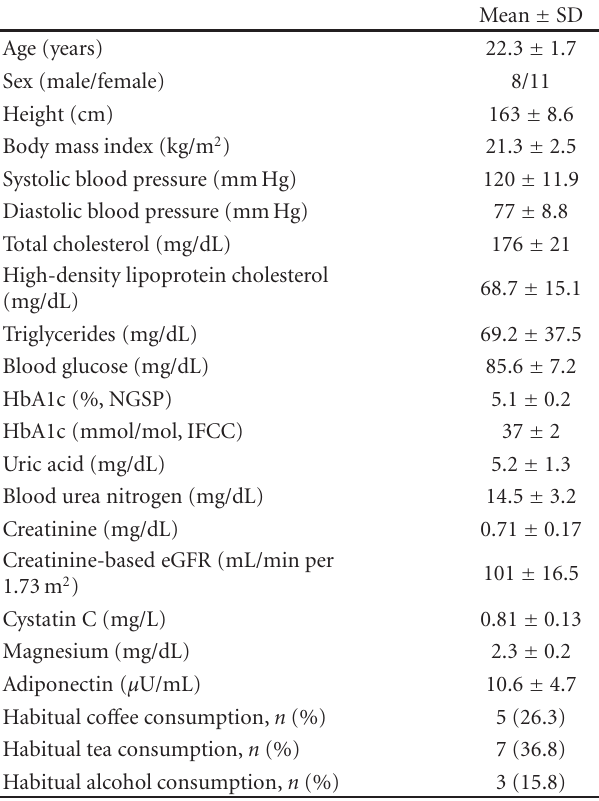
Table 1: Clinical characteristics of